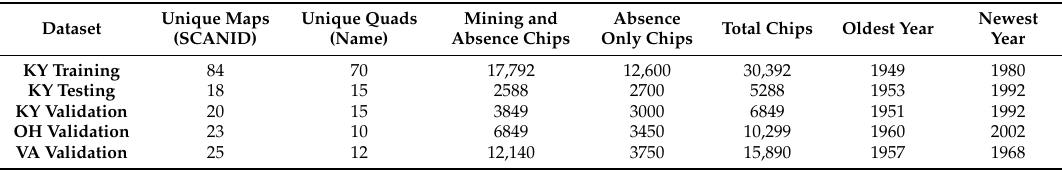
Table 1. Number of unique 1:24,000-scale, 7.5-minute topographic quadrangles within each dataset. A unique map is defined based on a SCANID. The Unique Quads column provides the number of unique quadrangle names in each dataset. The chips columns represent the number of 128-by-128 pixel chips in each dataset that contain mining and / or not mining pixels, only no mining pixels, and the total number of chips. The compilation years of the oldest and newest maps within each dataset are also